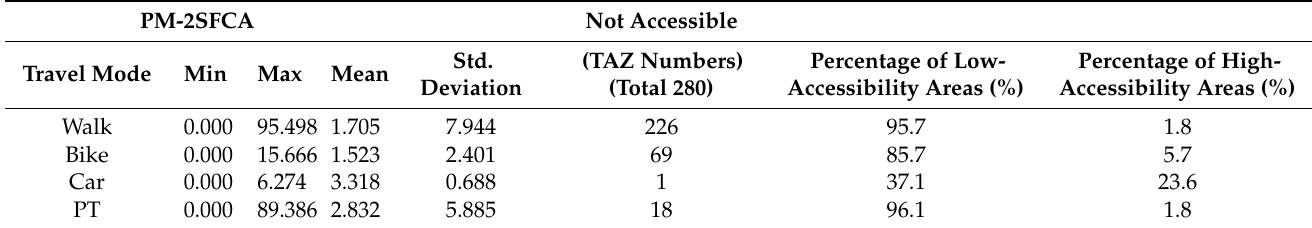
Table 4. The statistics on park accessibility under different travel